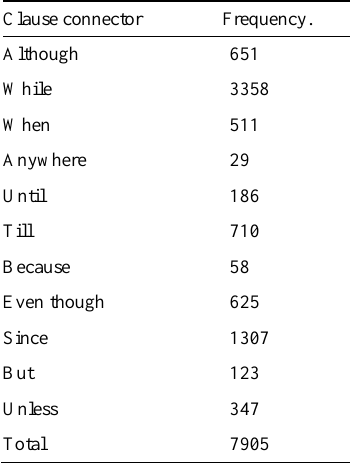
Table 2. Statistics of the most frequent clause connectors in negddi-drugbank